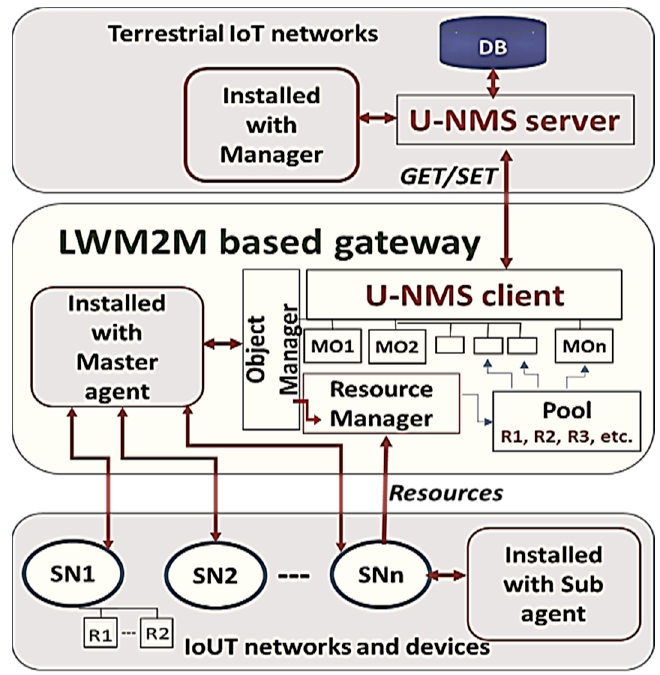
Figure 12. Block diagram of LWM2M based gateway design in U-NMS.